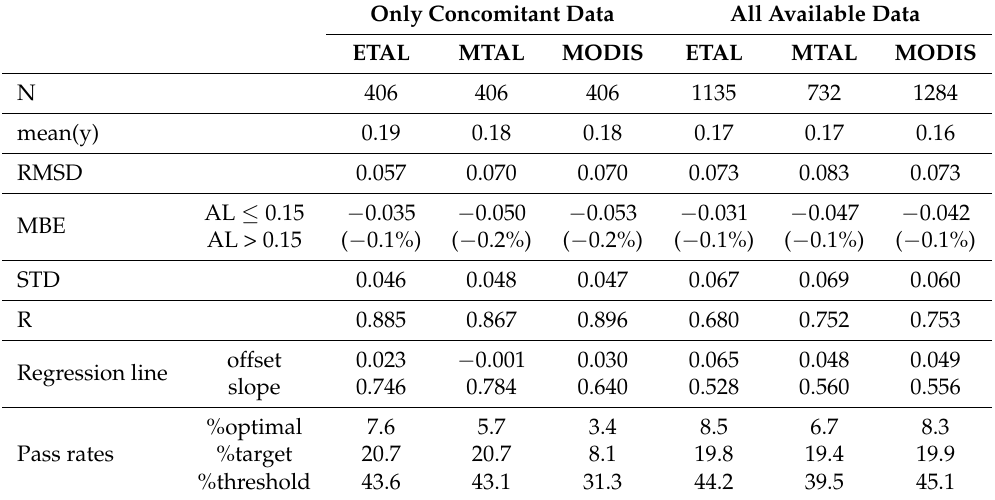
Table 9. Accuracy assessment of ETAL, MTAL and MODIS surface albedo satellite products versus ground measurements coming from GBOV, AMMA and BSRN stations during the 1 January 2015–31 December 2018 period when those dates that provided concomitant data for all three satellites products and ground measurements were considered (left) or simply using all data available (right). Absolute MBE are calculated over albedo values less 0.15 while relative MBE (in %) are calculated over albedo values greater than 0.15. Only Concomitant Data All Available